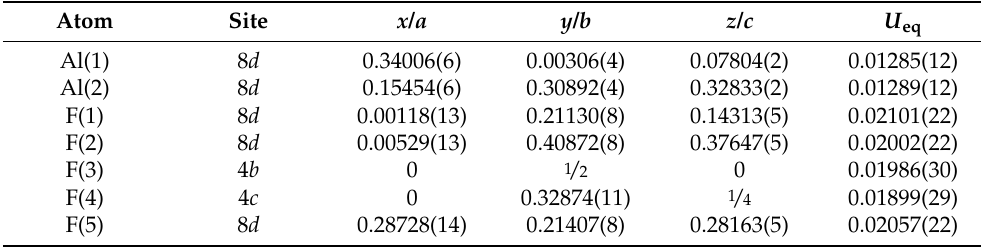
Table 3. Fractional atomic coordinates and equivalent isotropic displacement parameters (in 10 4 pm 2 ) for K 2 AlF 5